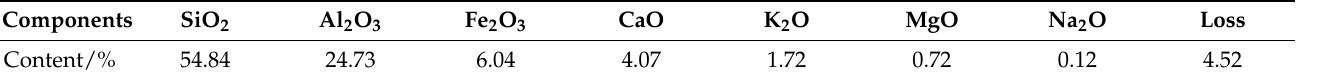
Table 2. Main components of fly ash.